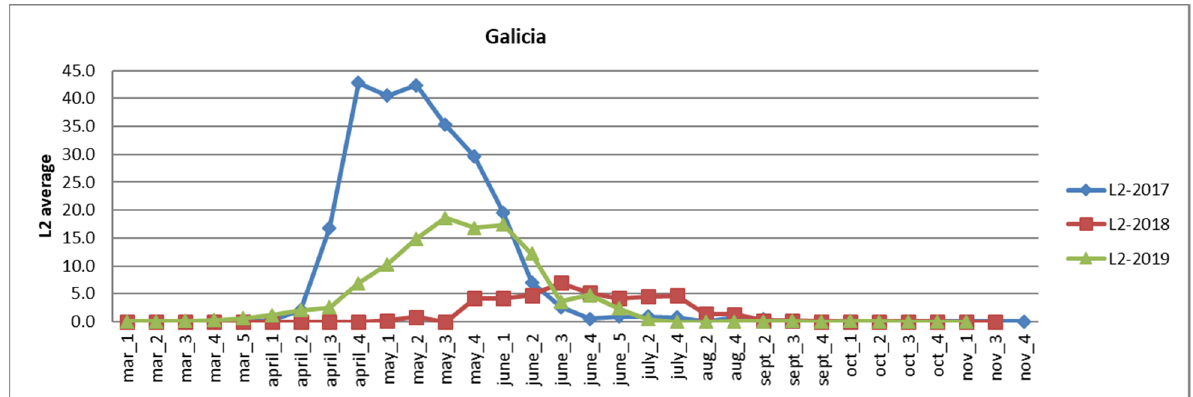
Figure 8. Evolution of the average number of larvae in stage L1, according to the week of the survey month.